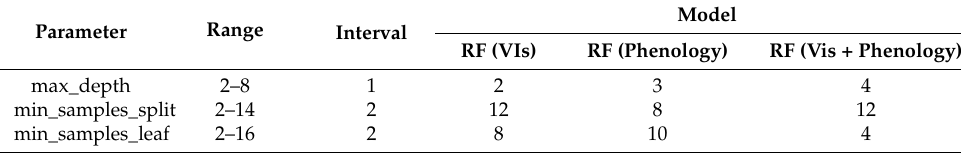
Table 3. Description of parameters tuned in RF regression